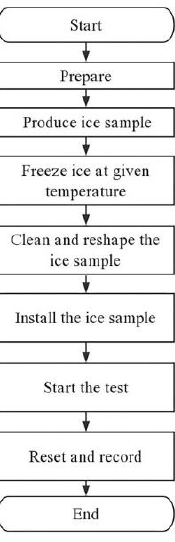
Figure 9. The 3D resin printing mold for the shear strength test.